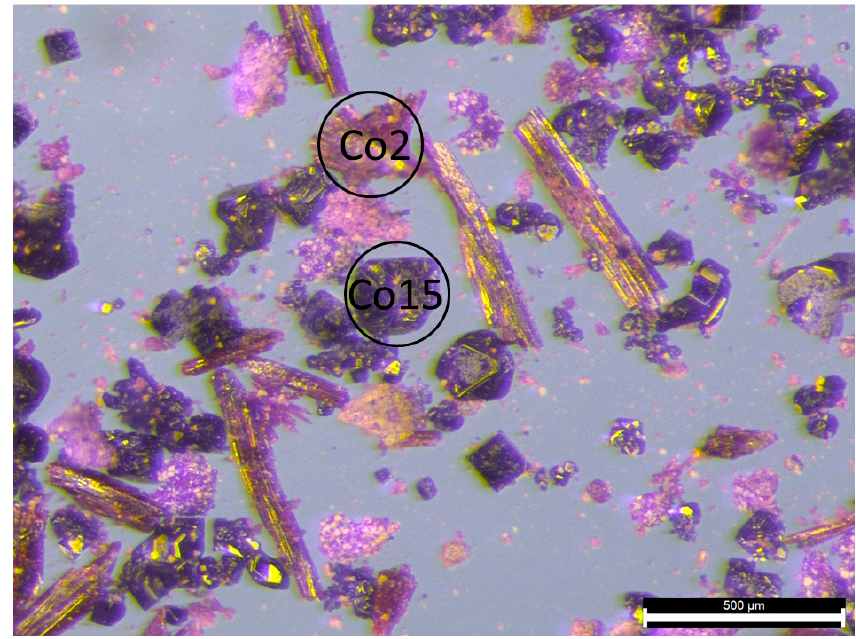
Figure 1. Typical crystal forms of hydrothermally grown crystals of Co 2 (TeO 3 )(OH) 2 (designated as Co2 in the inset) and Co 15 (TeO 3 ) 14 (OH) 2 (Co15). Powder X-ray diffraction (PXRD) measurements of the bulk products revealed Co 15 (TeO 3 ) 14 (OH) 2 , Co 2 (TeO 3 )(OH) 2 and Co 3 (TeO 3 ) 2 (OH) 2 in approximate weight percent- ages of 58%, 27% and 15%, respectively, for the batch with CoCO 3 , TeO 2 and KOH. For the batch starting with CoO, TeO 2 and Na 2 CO 3 , the products were Na 2 [Co 2 (TeO 3 ) 3 ]·3H 2 O, Co 15 (TeO 3 ) 14 (OH) 2 and Co 3 (TeO 3 ) 2 (OH) 2 in approximate weight percentages of 60%, 25% and 15%,